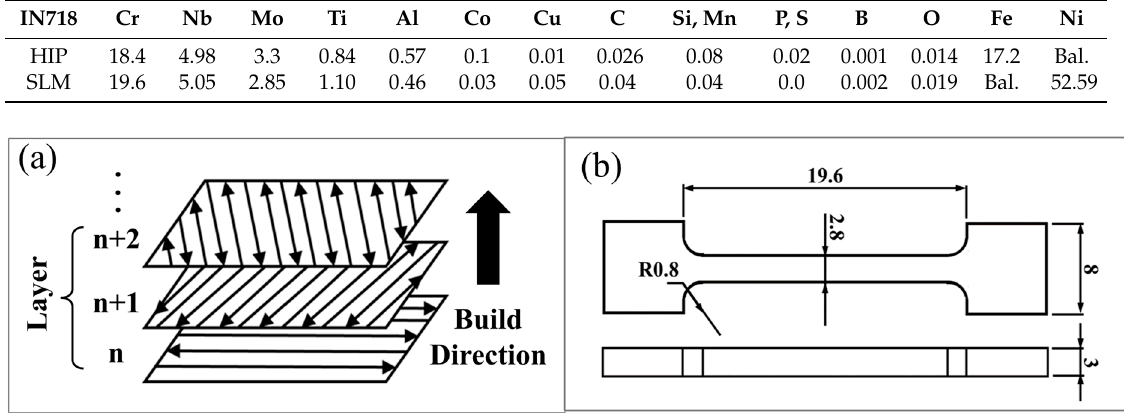
Figure 2. Illustrations of ( a ) scanning strategy of the SLM process and ( b ) dimensions of the mechanical test specimen (mm).